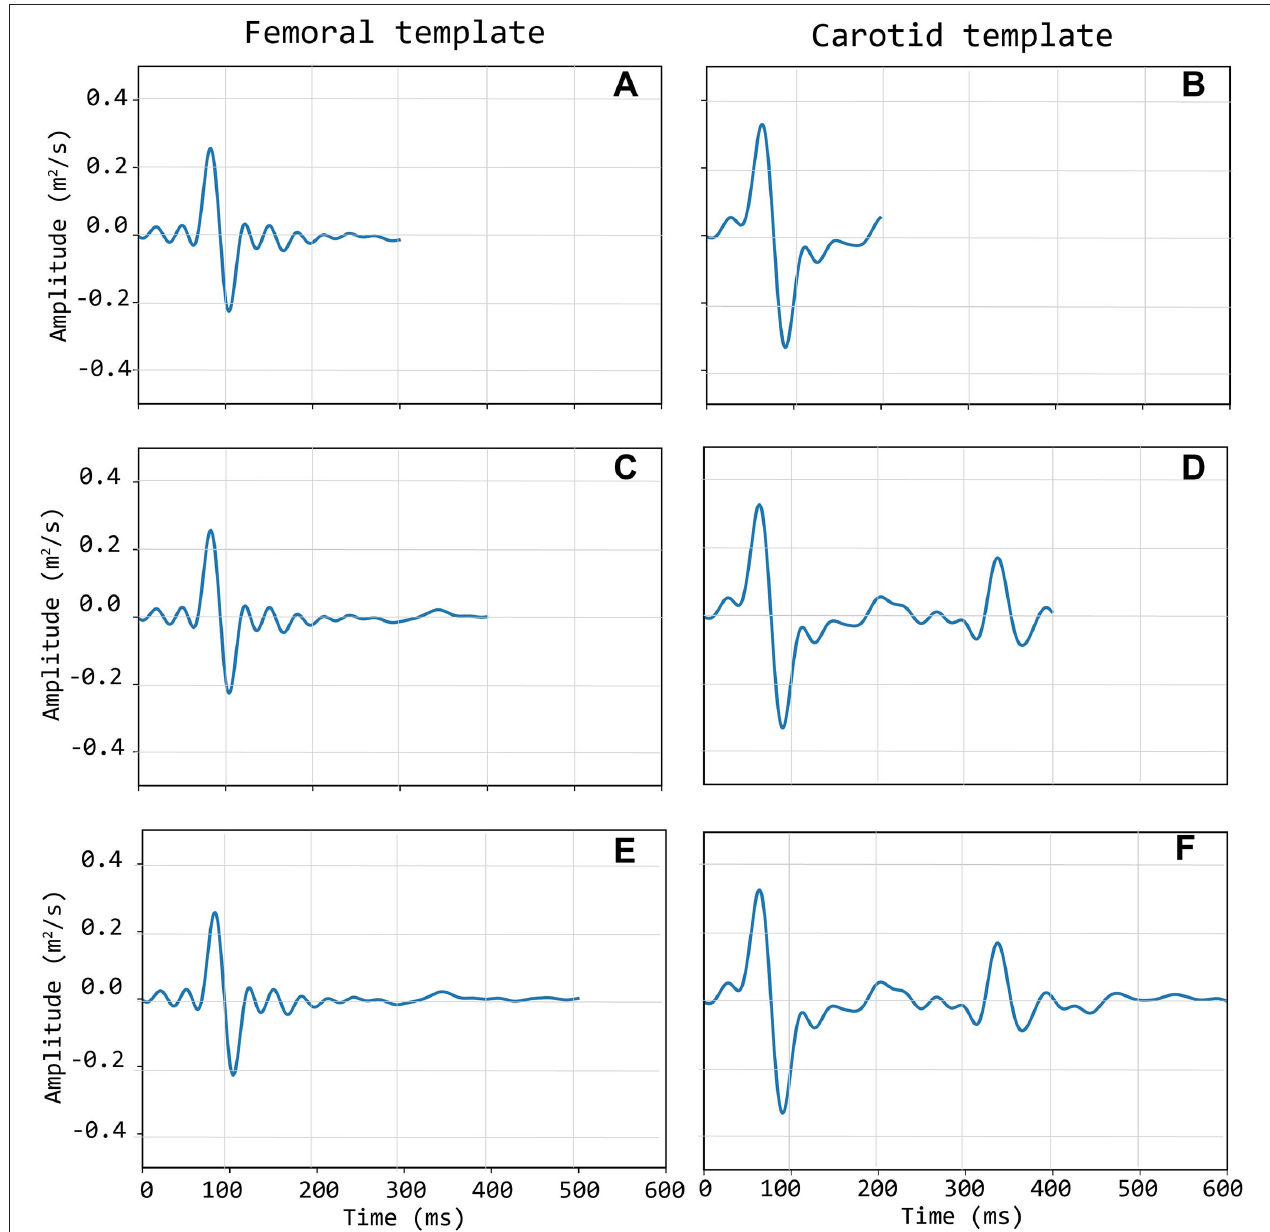
FIGURE 5 | Left column (A,C,E) : three different length of the femoral template; Right column (B,D,F) : three different lengths of the carotid template.